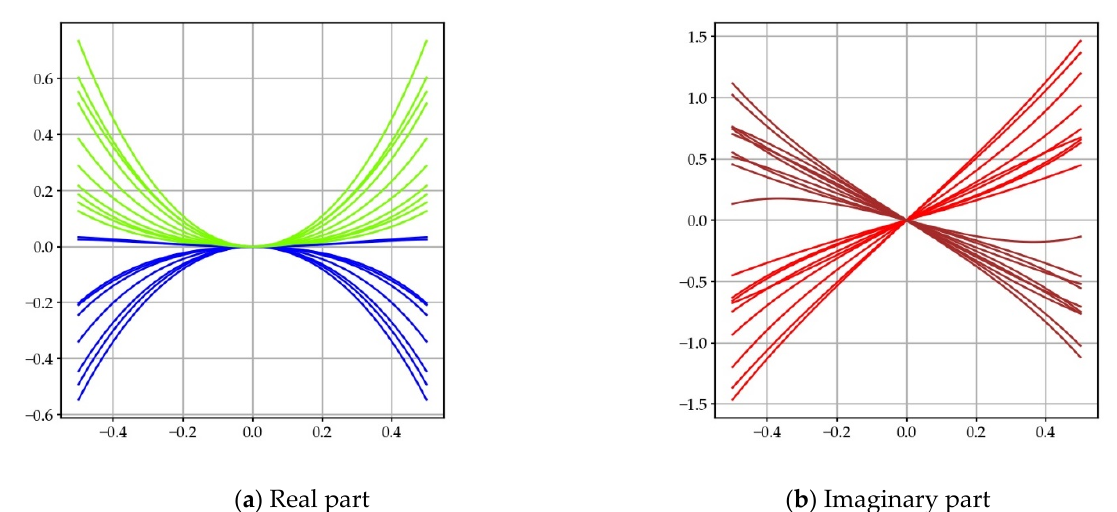
Figure 11. Drawings of several F cross-sections, when s p is a zero. On these different cross-sections at constant y of the F function, we observe the two symmetries which are characteristic of the function. The two real and imaginary parts are equal to zero for x = 1 / 2 , since they are cross-sections corresponding to non-trivial zeros. The colors are different depending on whether they are zeros with an odd or even index.